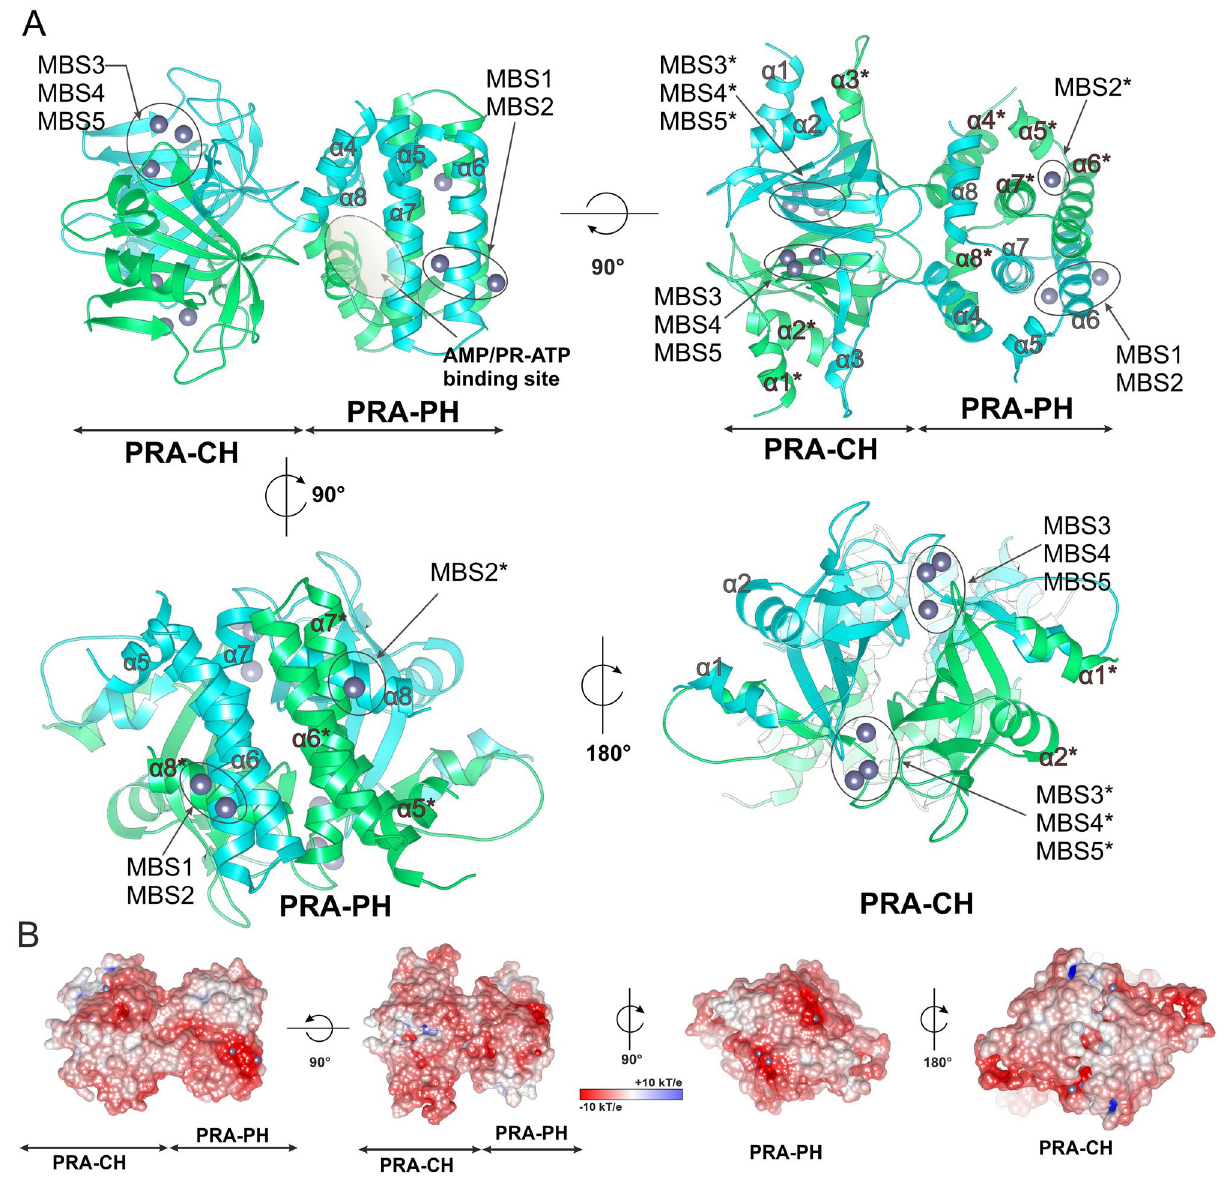
Figure 3. Structure of unliganded Mt HISN2. ( A ) Ribbon representation of the Mt HISN2 dimer; the metal- binding sites (MBSs) containing Zn 2+ (dim gray) are marked in elipses; the AMP/PR-ATP binding site in the PRA-PH domain is marked in a dashed elipse. Notice overlapping chain A (light green) and chain B (cyan) that form well-separated domains of PRA-PH and PRA-CH activities. Asterisks (*) represent elements of symmetric subunits. ( B ) Surface electrostatic potential of Mt HISN2 is color-coded as shown in a bar. Protein rotations correspond to panel A ,